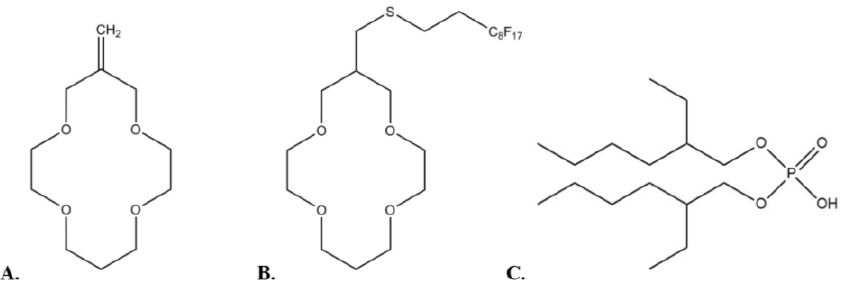
Figure 20. Crown ether and organophosphate extractants used with supercritical carbon dioxide as the solvent (( A ). methylene-14-crown-4 (M14C4), ( B ). fluorinated 14-crown-4 (F14C4), ( C ). HDEHP [189,190]. Reprinted (adapted) with permission from Pálsdóttir, A. et al. Characterization of 14-Crown-4 Ethers for the Extraction of Lithium from Natural Brines: Synthesis, Solubility Measurements in Supercritical Carbon Dioxide, and Thermodynamic Modeling. Ind. Eng. Chem. Res. 2021 , 60, 7926–7934. Copyright 2021 American Chemical Society.